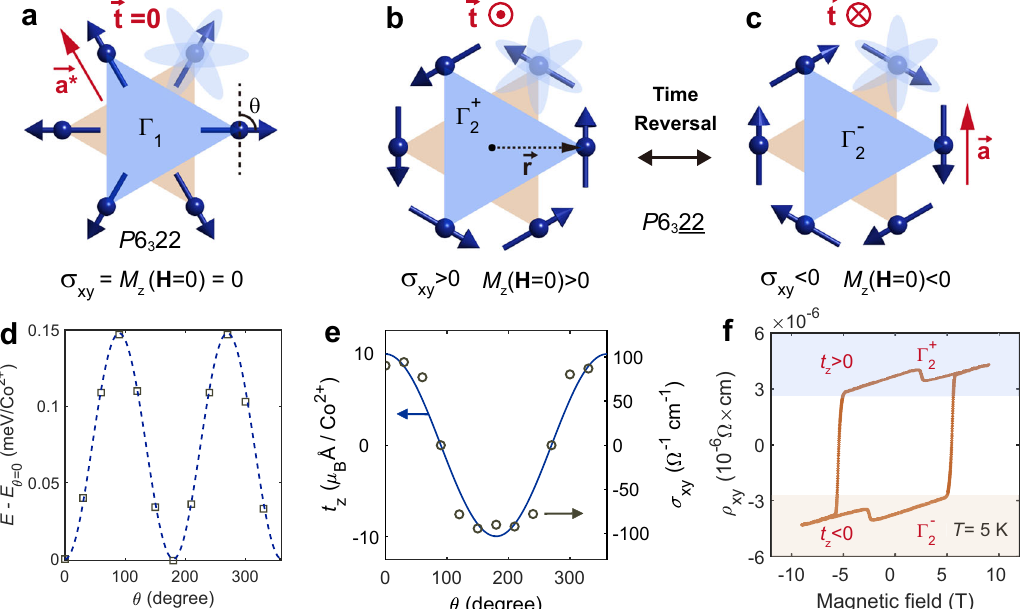
Fig. 3 Interplay between a fi eld-tunable toroidal moment and AHE. a The Γ 1 spin con fi guration having a magnetic space group P 6 3 22, in which the symmetry forbids fi nite σ xy ð H ¼ 0 Þ and M z ð H ¼ 0 Þ . b , c The Γ 2 spin con fi guration having a magnetic space group P 6 3 22. No symmetry operation forces σ xy and M z to vanish. Three sky-blue ellipses in a , b denote the three-fold easy-axes to realize the Γ 1 or Γ 2 ground state, respectively. d Total energy from the DFT calculation as a function of the uniform spin rotation angle θ shown in a . e Comparison between a toroidal moment along the c -axis (a solid blue line) and calculated σ xy for the spin con fi gurations speci fi ed by θ in a (black circles). f Interpreting the sign change of AHE as a switch of the toroidal moment. A blue (orange) rectangle denotes a region of the Γ þ con fi